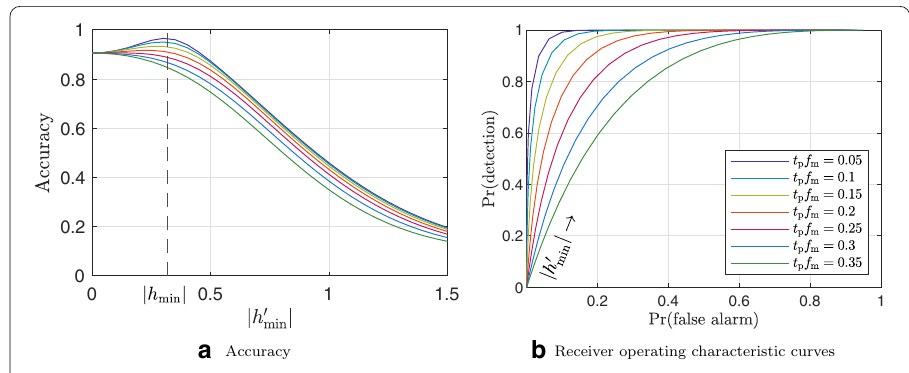
Fig. 11 Analysis of the outage prediction performance using common binary classification metrics. 20 dB SNR, F = 10dB , (cid:31) tf m = 0.05 and M =